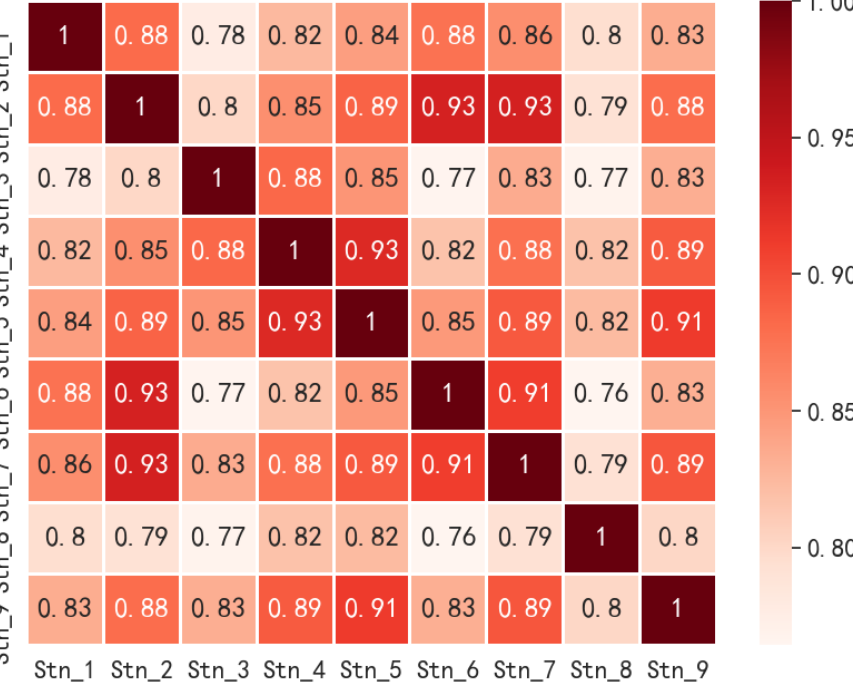
Figure 6. Correlation coefficient between stations.